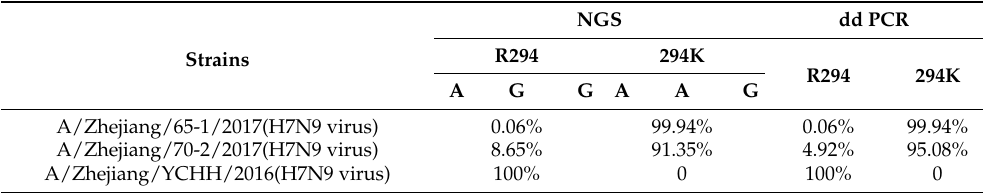
Figure 3. A/Zhejiang/65-1/2017 (H7N9 virus) ( A ) and A/Zhejiang/70-2/2017 (H7N9 virus) ( B ) detected in eight replicates by RT-dd PCR. Note: The X-axis represents the results of clinical samples from 8 parallel tests, while the Y-axis indicates the number of gene copies per microliter of reaction system for FAM and VIC channels. Table 4. The proportion of R294K mutant copies detected by RT-dd PCR and